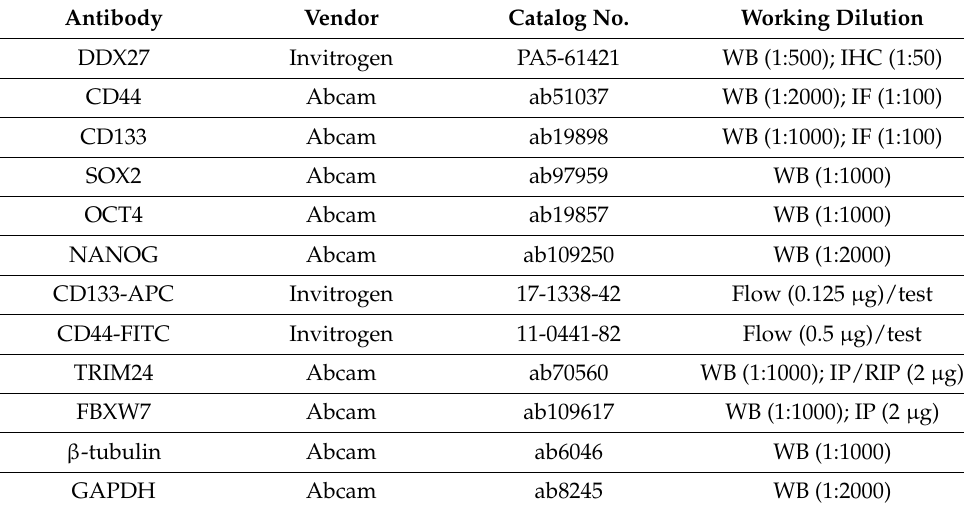
Table 2. Antibodies used in this